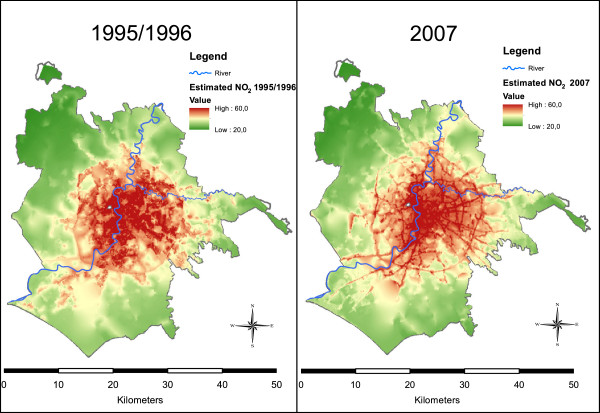
Maps of Rome with predicted NO2levels in 1995/96 and in 2007.